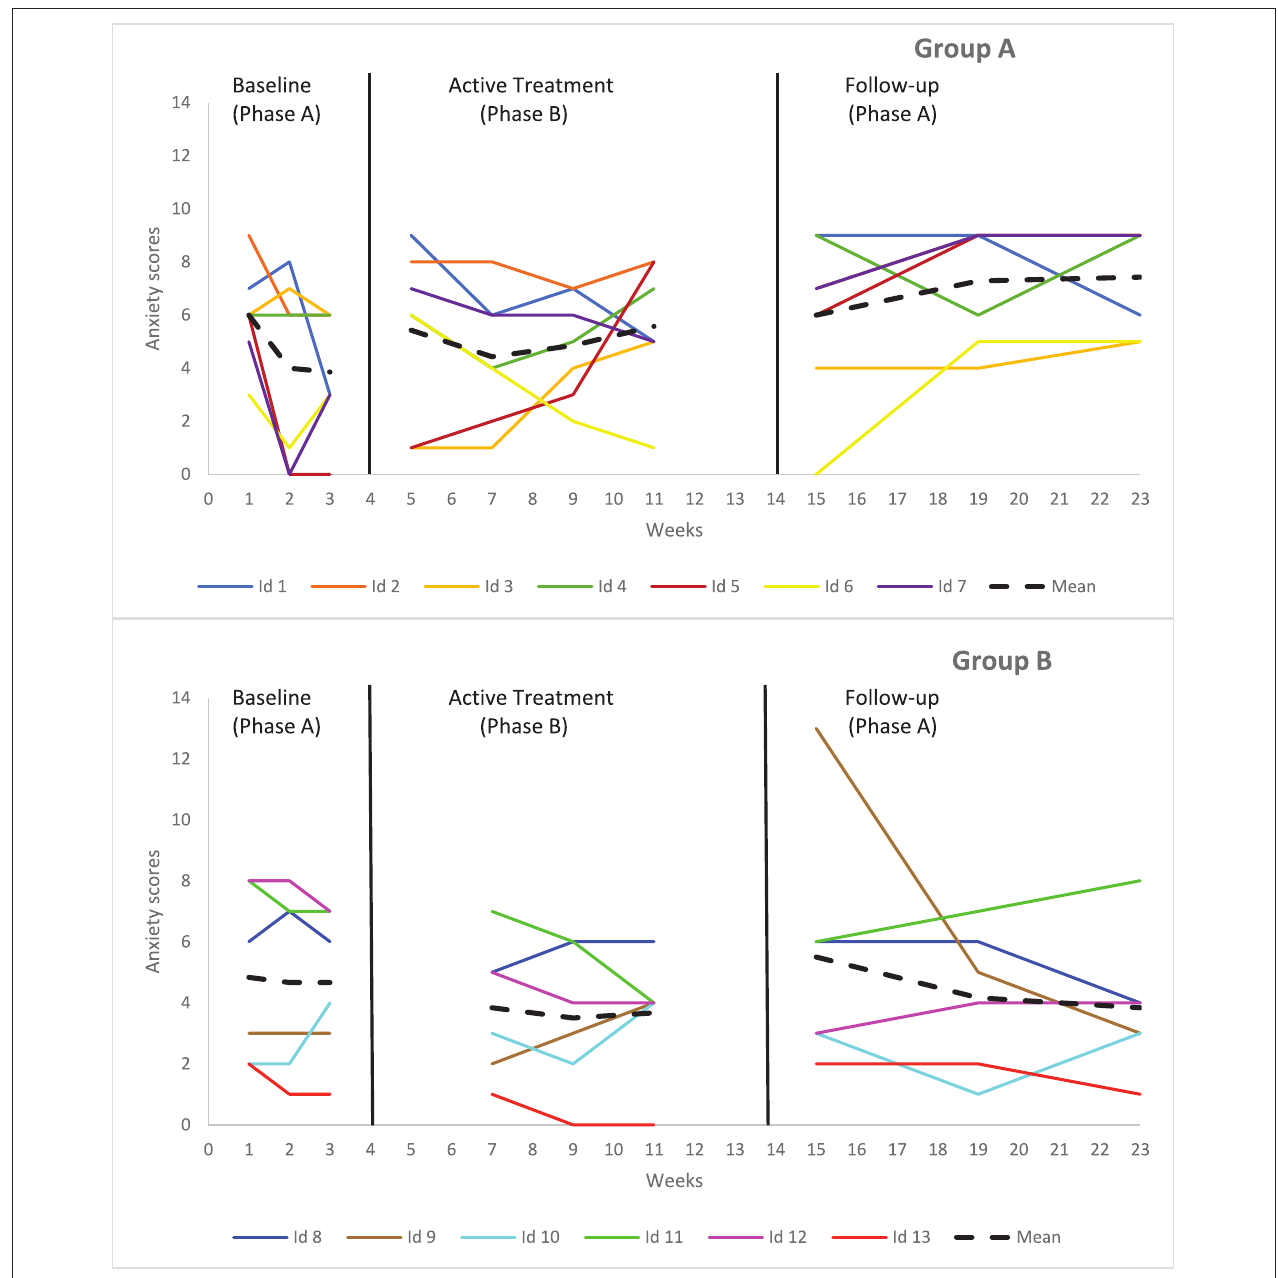
FIGURE 6 | Graphical display of baseline level and changes in level between consecutive phases in anxiety for teacher-reported